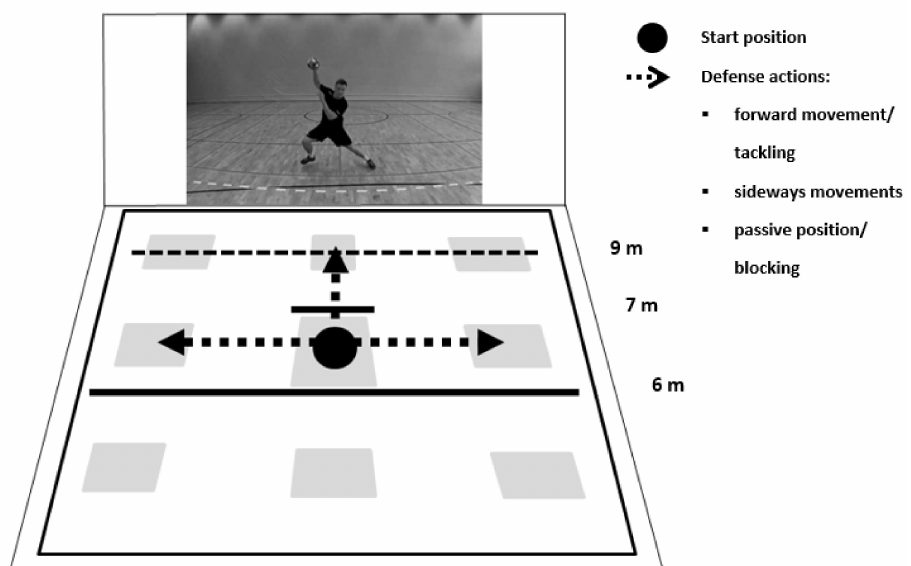
Figure 3. Motor responses as defensive actions with respective contact plates on the SpeedCourt ® in front of the projection